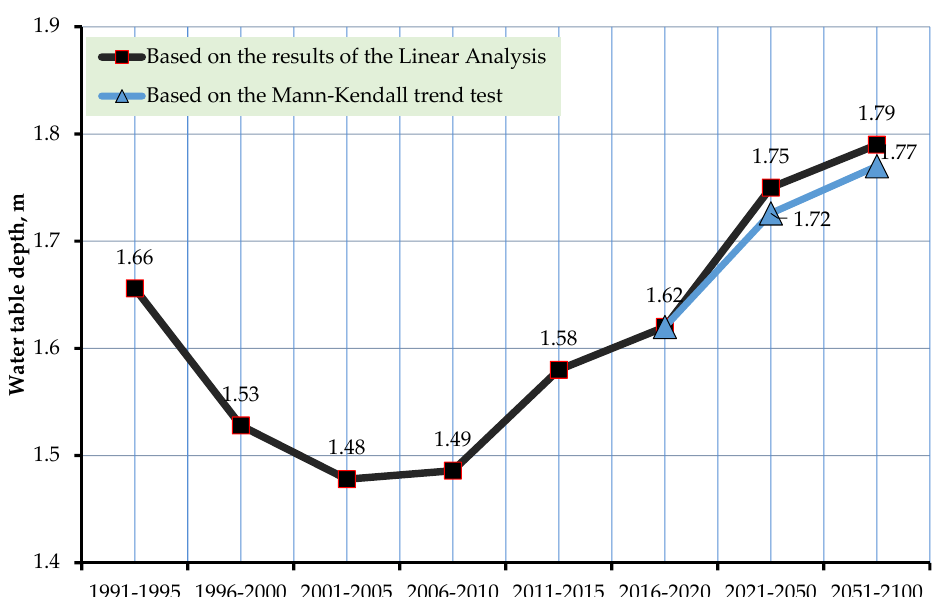
Figure 4. Predictions of groundwater salinity.